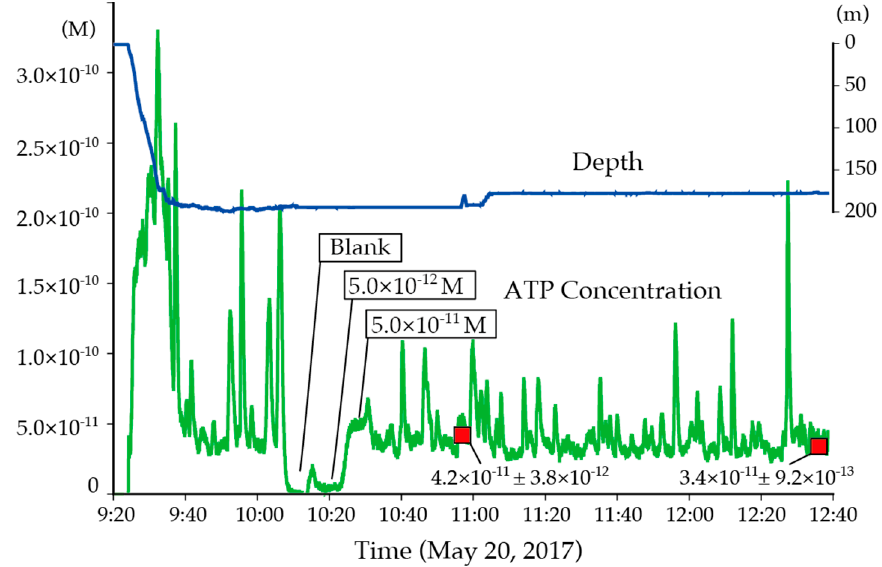
Figure 9. Result of in situ ATP measurement at the Oomuro Hole during the 2021st dive of HYPER-DOLPHIN. Raw bioluminescence data were converted to ATP concentration and plotted as the green line with time. The time was shifted 3 min ahead considering the time-lag between sample intake and bioluminescence emission in the analyzer. The depth profile measured by a depth sensor on the ROV is shown in the blue line. ATP concentrations measured onboard using the collected water samples were shown as red squares.